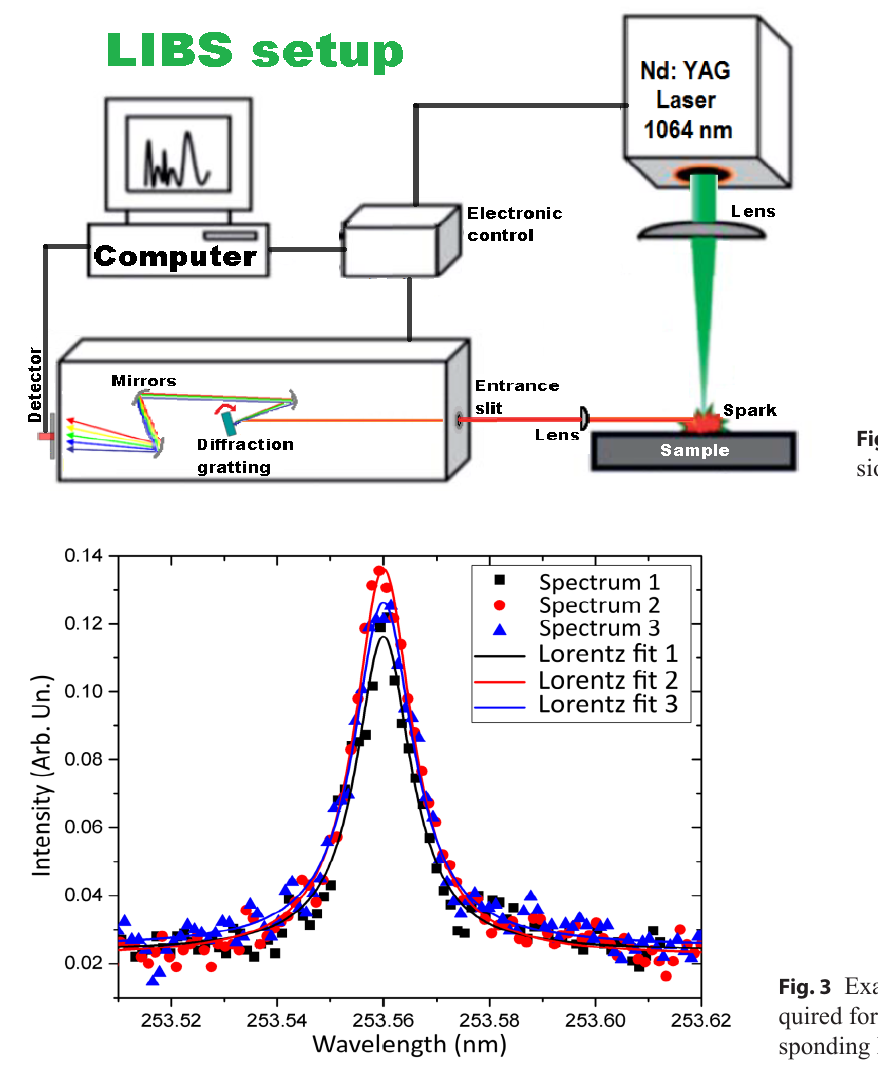
Fig. 2 LIBS setup for